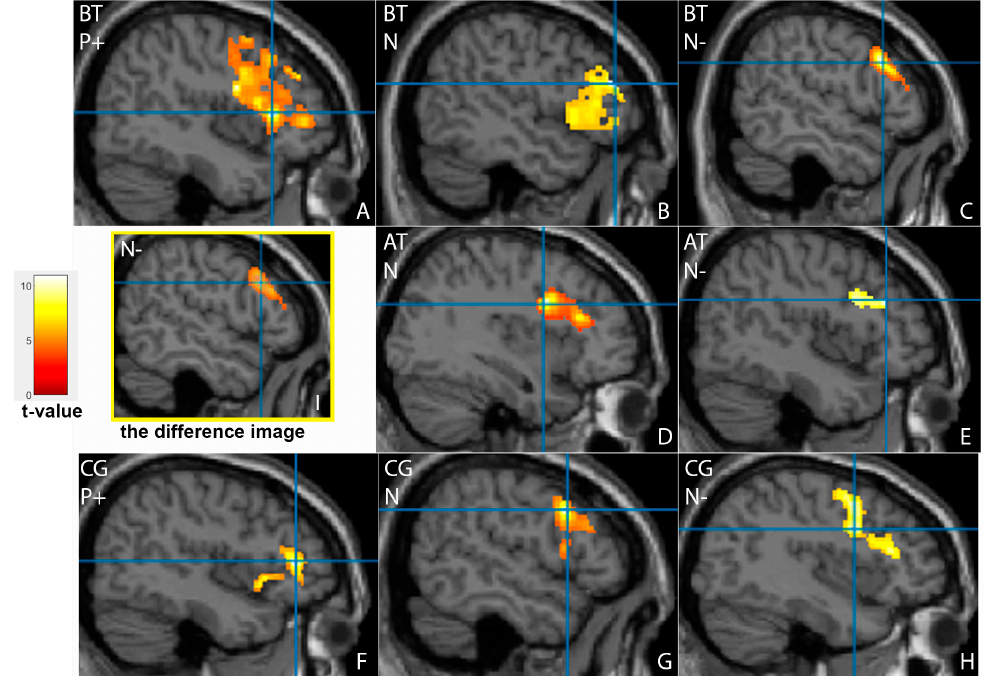
Figure 2. Activation of the frontal cortex in patients before (BT) ( A – C ), after (AT) ( D – E ) antidepressant therapy and in healthy controls (CG) ( F – H ) during facial emotion recognition. Demonstration of positive, happy faces (P+) ( A , F ), neutral emotionless faces (N) ( B , D , G ) and negative, sad faces (N ‐ ) ( C , E , H) . The corresponding difference image ( I ) showed a significant decrease of activation area in the right middle frontal gyrus for negative faces ( p < 0.001).